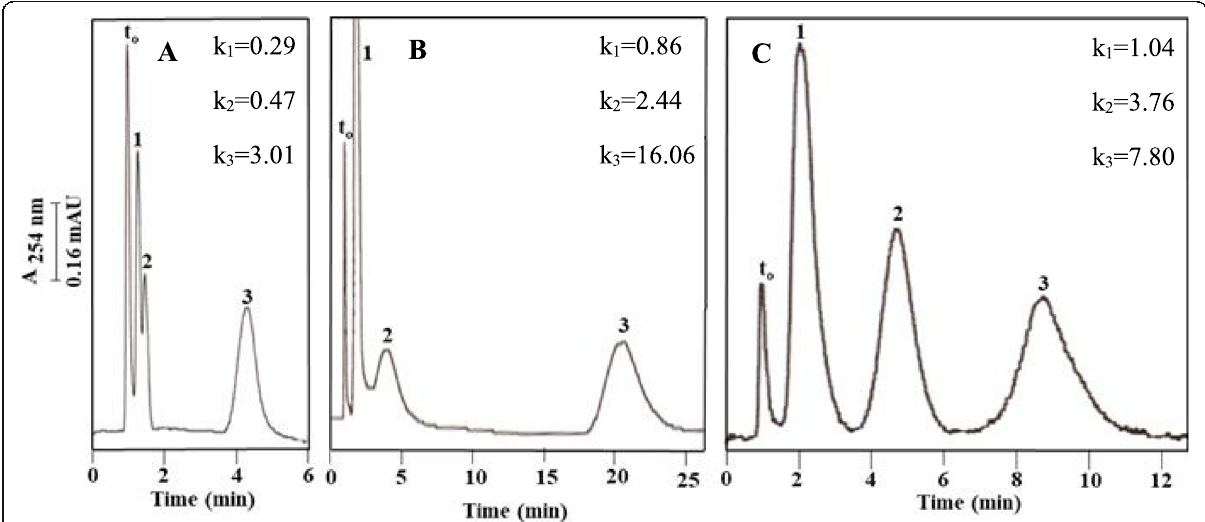
Fig. 3 Chromatograms of some food additives ( a ), vitamins ( b ), and biological amines ( c ) obtained on FSNPs-poly(GMM-co-EDMA) monolithic column. Separation conditions: column, 10 cm × 4.6 mm i.d. at 0.6 mg of FSNPs/cm; flow rate, 1 mL/min; injection volume, 20 μ L; column temperature, room temperature. For a , mobile phase, 90% ACN (v/v), 10% of 10 mM ammonium acetate, pH 3.0 (v/v); solutes: 1, benzoic acid; 2, maleic acid; 3, ascorbic acid; t 0 , phenyl heptane. For b , mobile phase, 90% ACN (v/v), 10% of 10 mM ammonium acetate, pH 6.0 (v/v); solutes: 1, nicotinamide; 2, riboflavin; 3, thiamine; t 0 , toluene. For c , mobile phase, 95% ACN (v/v), 5% of 200 mM ammonium acetate, pH 5.0 (v/v); solutes: 1, (±)-phenylpropanolamine; 2, (±)-propranolol; 3, (±)-ephedrine; t 0 , phenyl